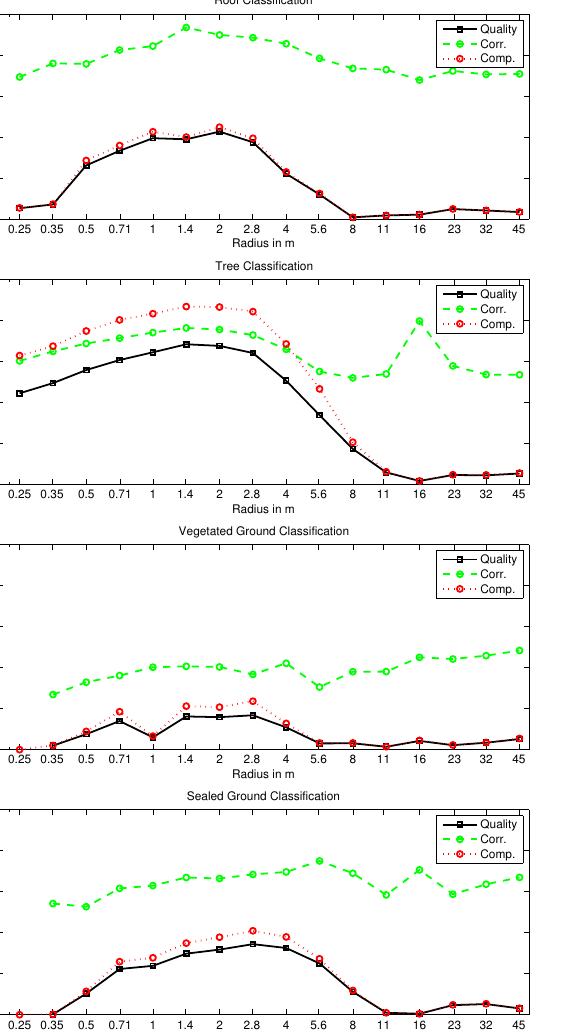
Figure 2: Evaluation of classification results exclusively employ- ing shape distribution features for different neighbourhood sizes. Quality measures are calculated according to Section 4.1 and plotted against the radius of a cylindrical neighbourhood.